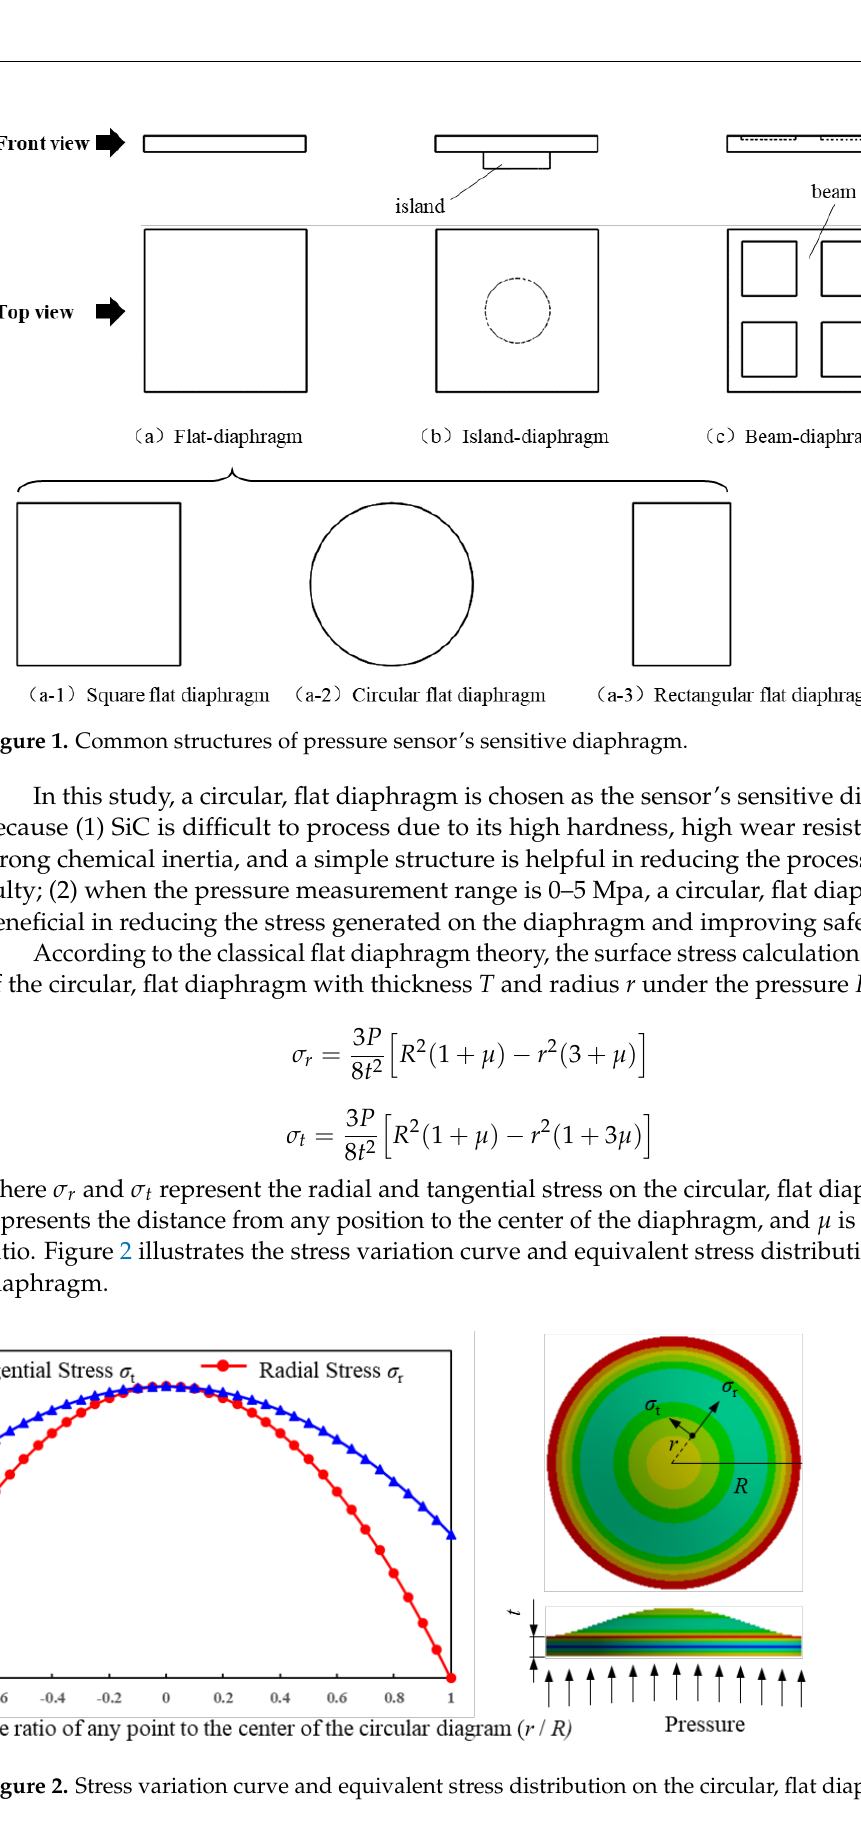
Figure 2. Stress variation curve and equivalent stress distribution on the circular, flat